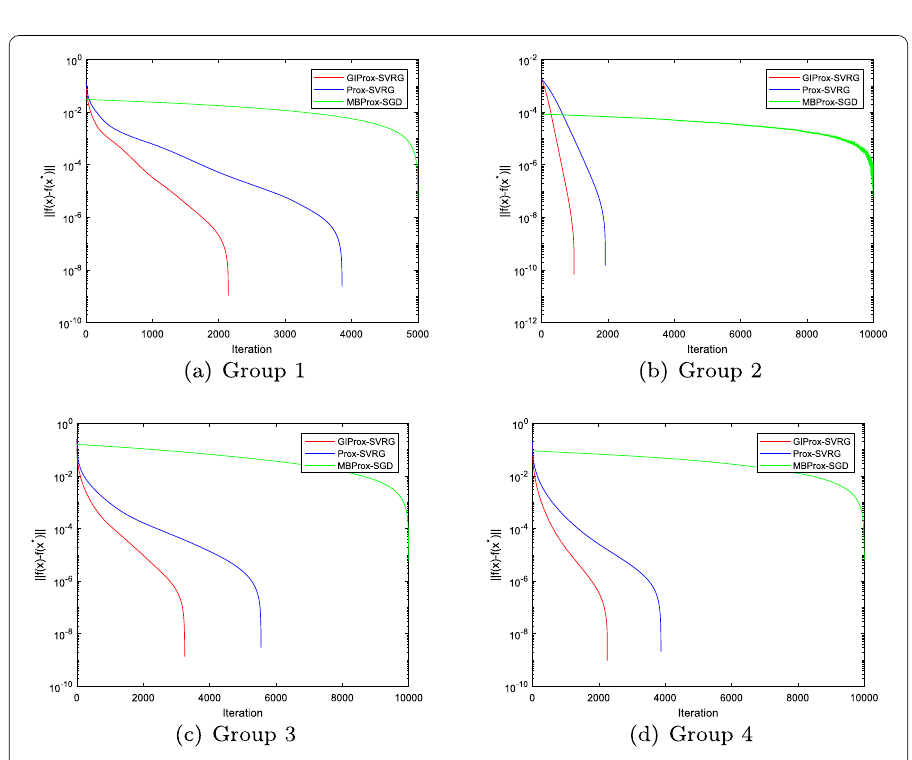
Figure 2 The change curve of objective function value of different algorithms on sigmod